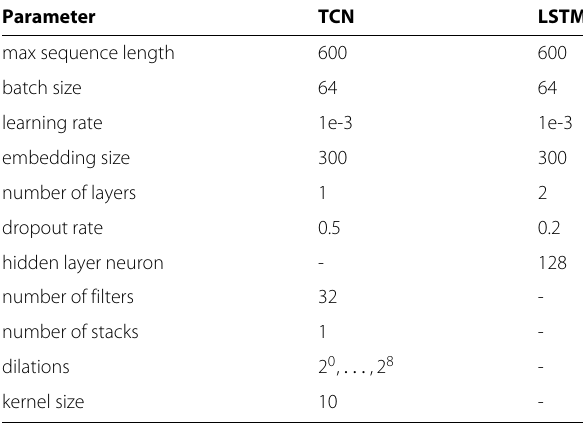
Table 1 Parameters selection